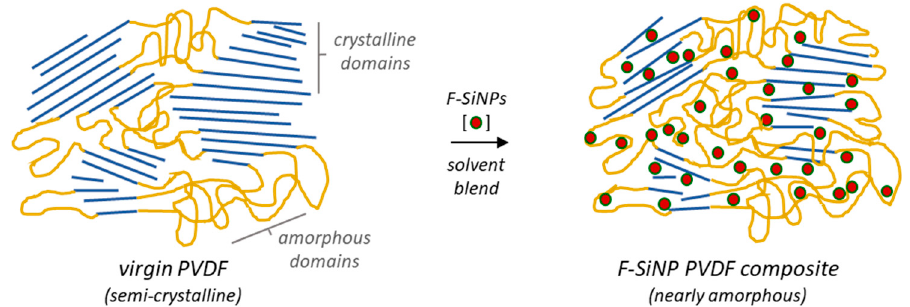
Figure 1. Illustrated depiction of a surface-modified fluorinated silica nanoparticle and their arrangement in the PVDF amorphous and crystalline microstructure (not to scale).